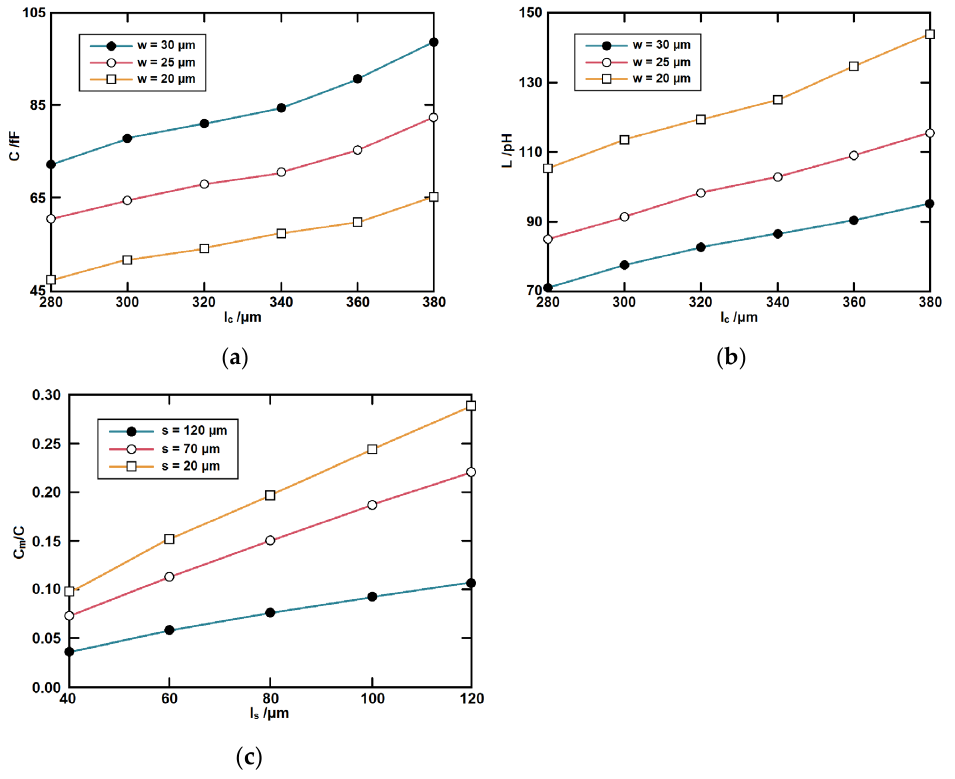
Figure 13. The component values with respect to dimensions ( a ) C , ( b ) L , and ( c ) C m .